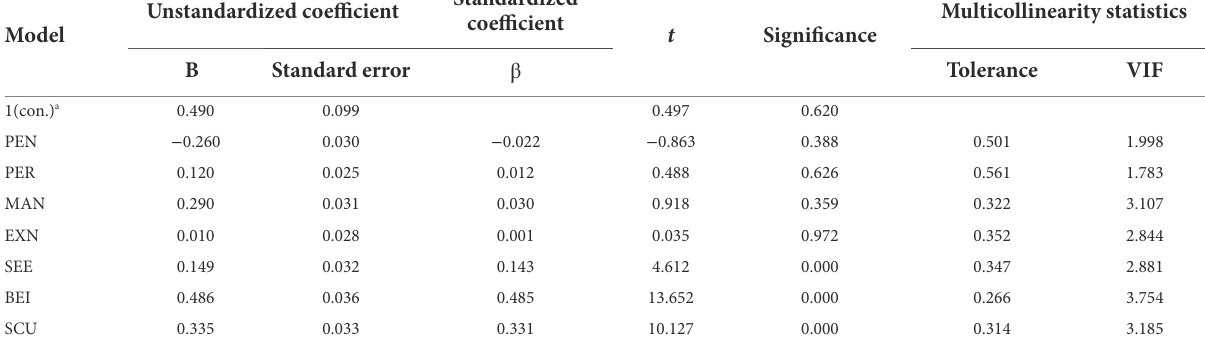
TABLE 4 Results of multicollinearity analysis.